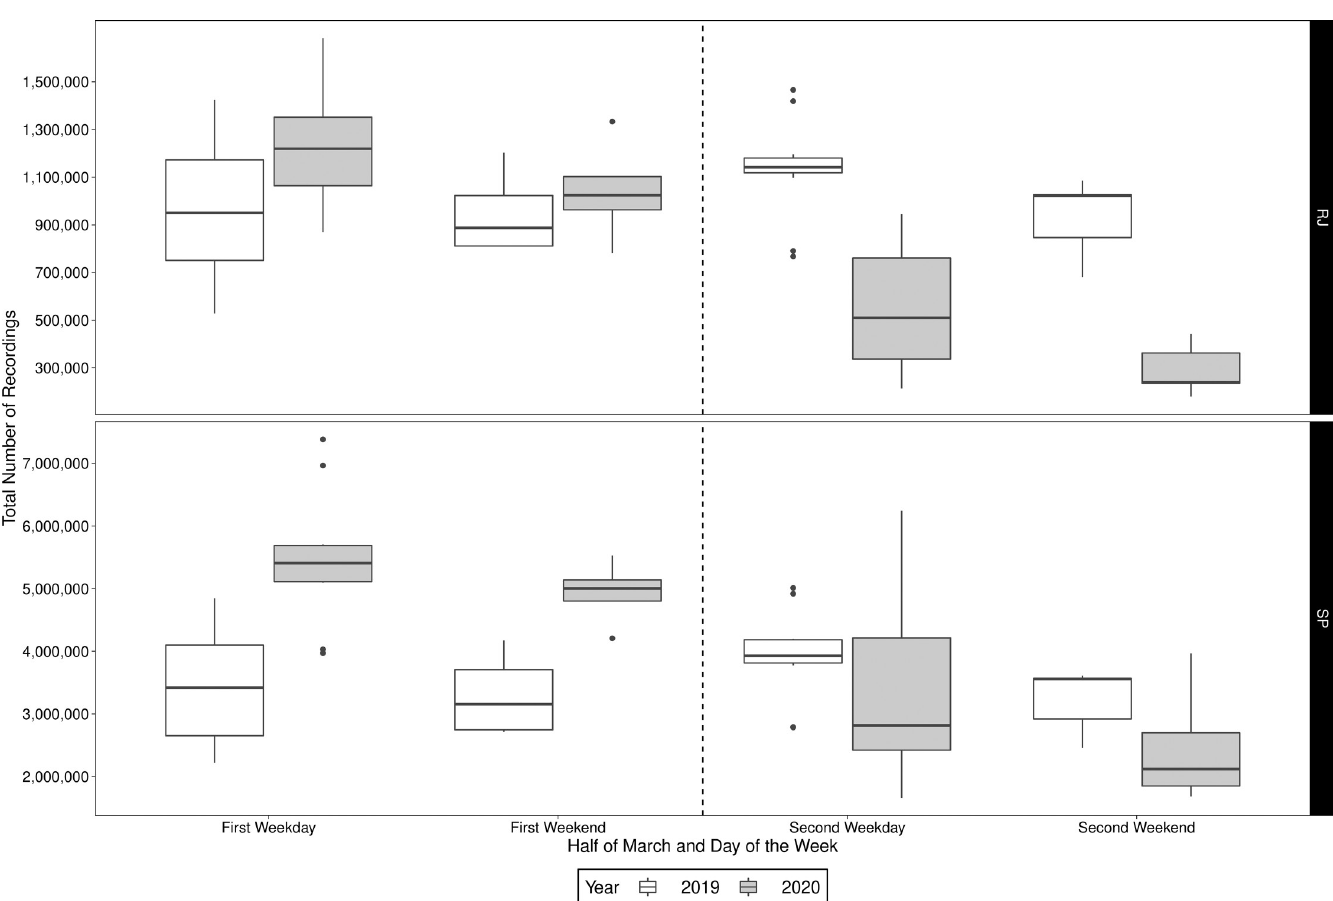
Fig 2. Box-plot of the total number of recordings on the first (from the 1 st to the 14 th ) and second (from the 15 th to the 30 th ) half of March, in weekdays and weekends, in 2019 and 2020 for both states.